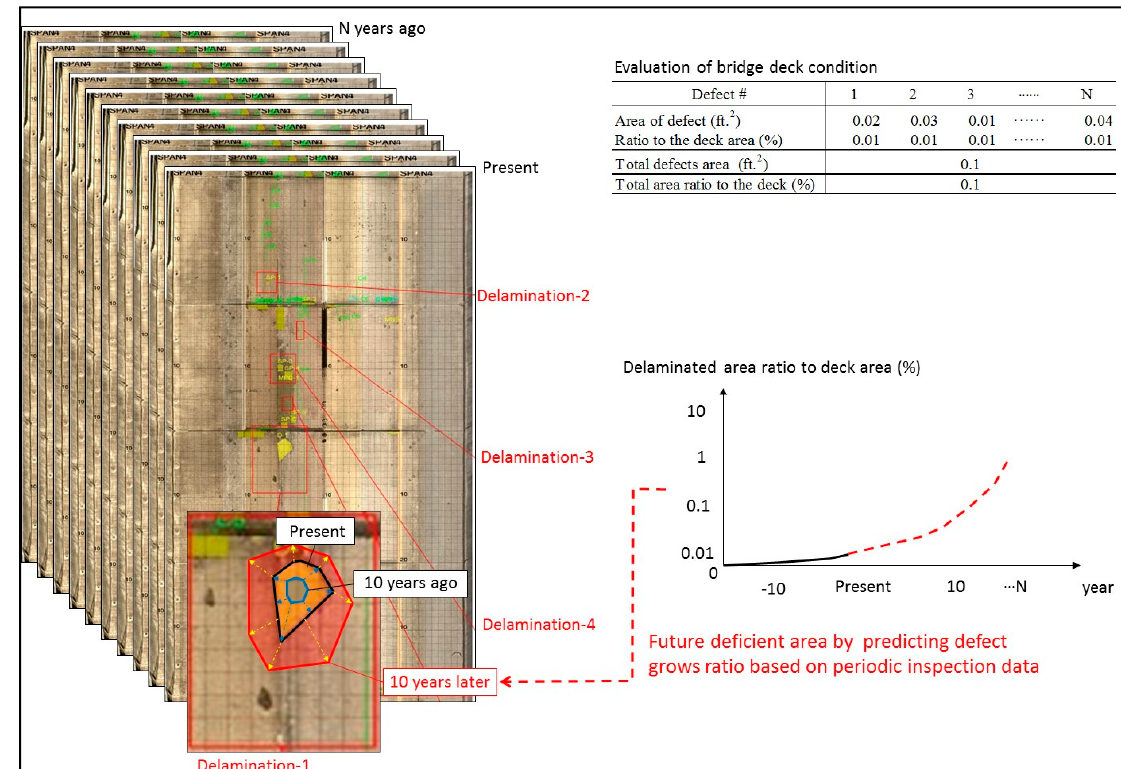
Figure 2. Example utilization of NDE for bridge management [16].